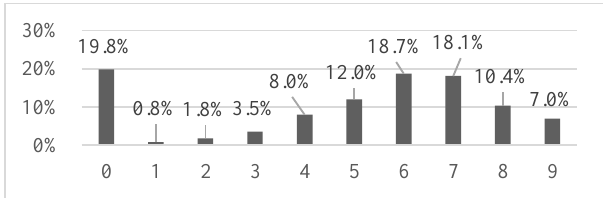
Figure 13 . Place of troubleshooters in the order of solving.